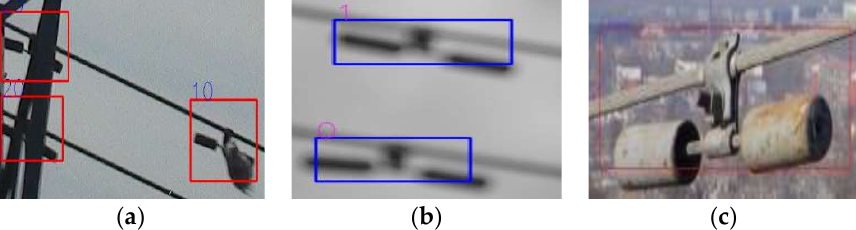
Figure 11. Detection results for difficult samples. ( a ) Obscured vibration-dampers; ( b ) fuzzy vibration-dampers; ( c ) vibration-dampers with color variation.